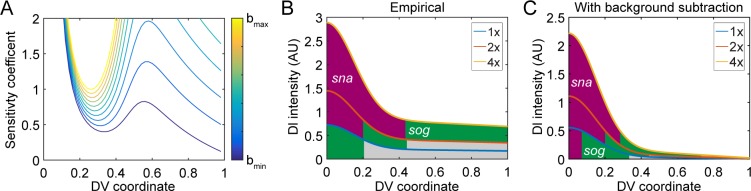
Theoretical consideration of the sensitivity coefficient.(A) Testing whether a lower value of the parameter b could result in a lower sensitivity. (B) The empirical prediction shows that 1x embryos completely lose sna expression, while 4x embryos have an overexpanded domain of sna, and lose dpp completely. (C) The prediction when lower b values were used.